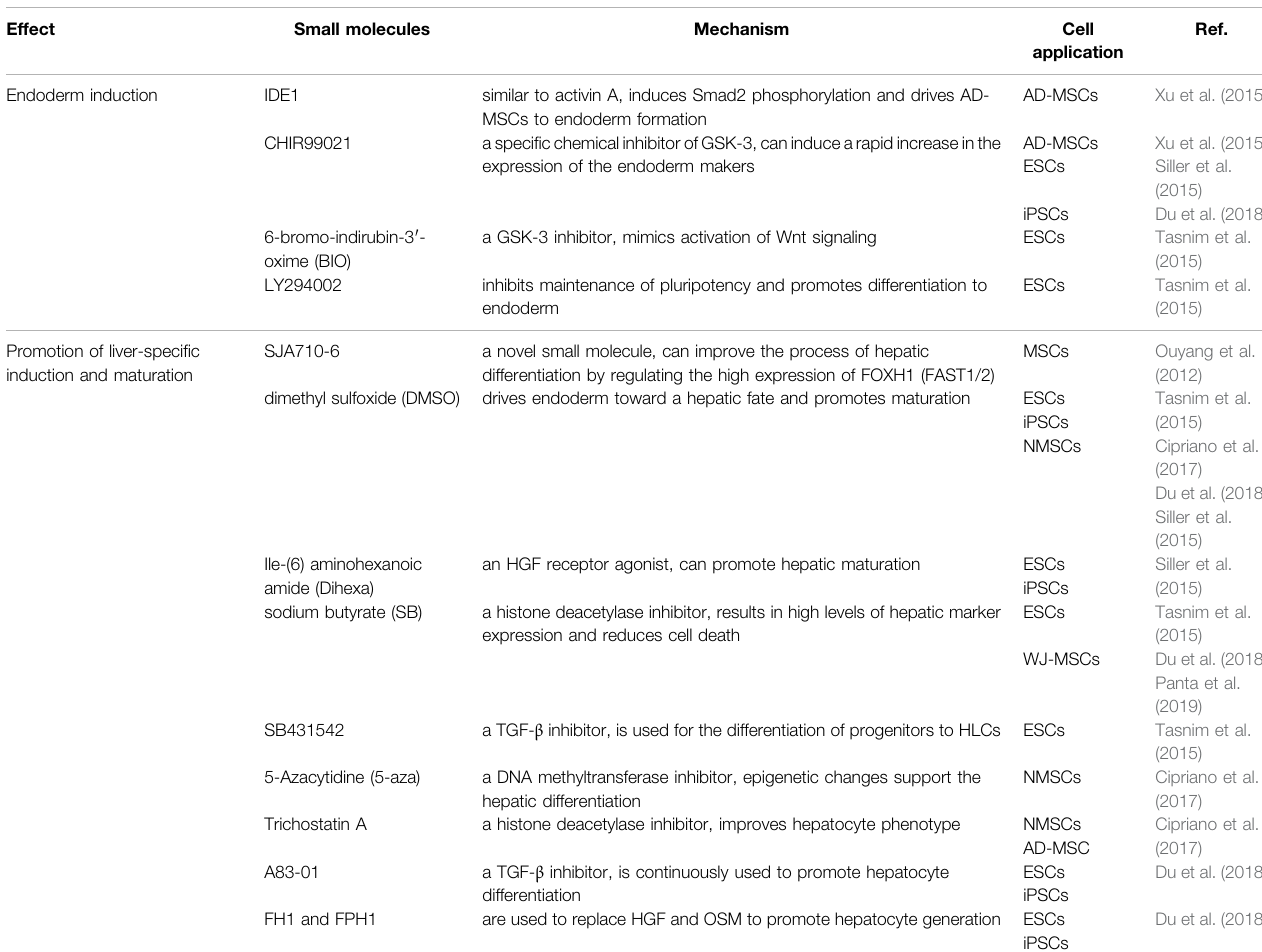
TABLE 2 | Small molecules and possible mechanisms in HLCs